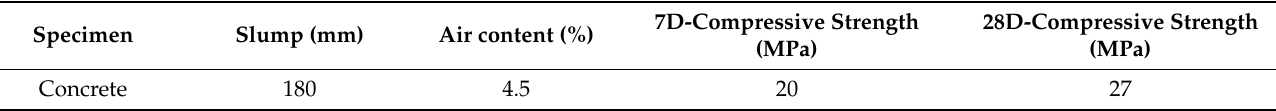
Table 6. Physical properties of the concrete used in this